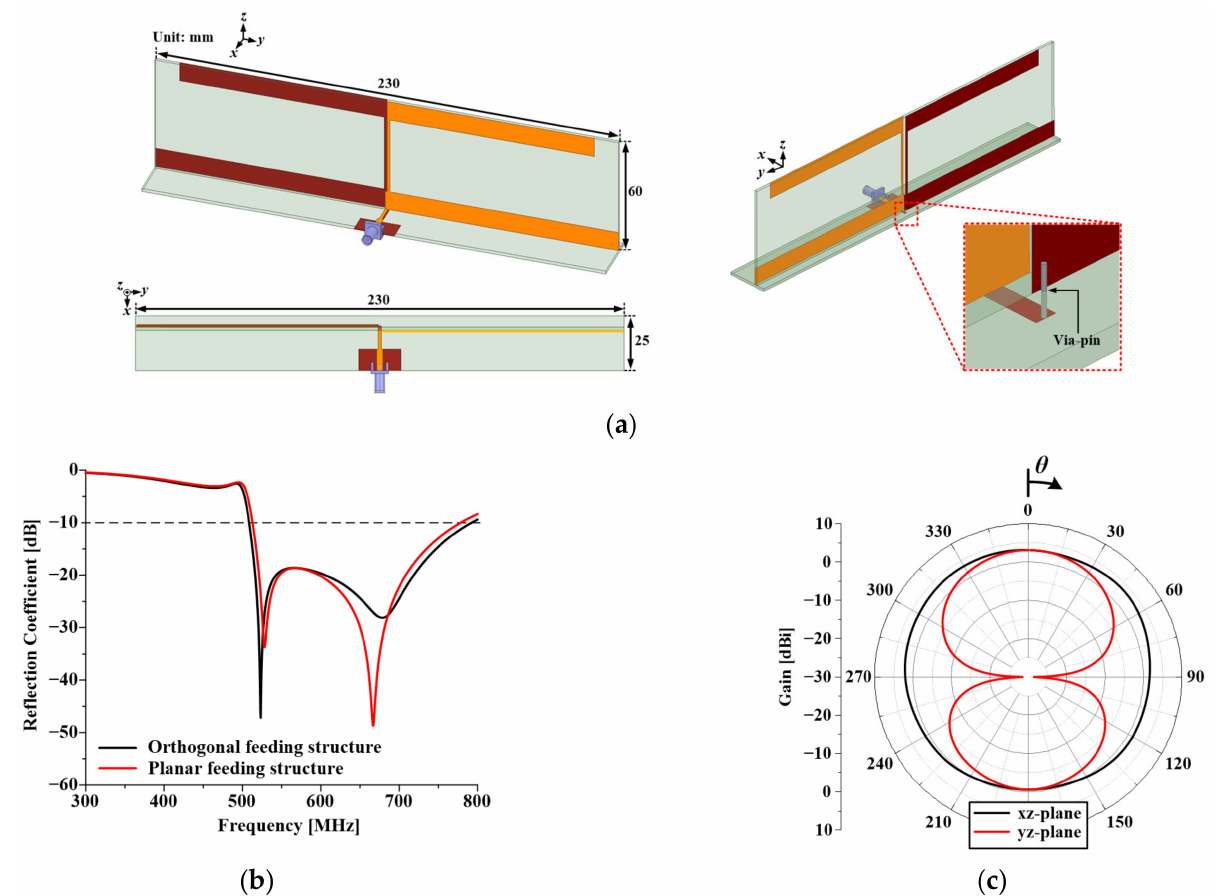
Figure 8. Orthogonal feeding structure of a single dipole antenna: ( a ) geometry of antenna, ( b ) simulated reflection coefficient performances depending on feeding structures, and ( c ) simulated radiation patterns at 580 MHz with orthogonal feeding